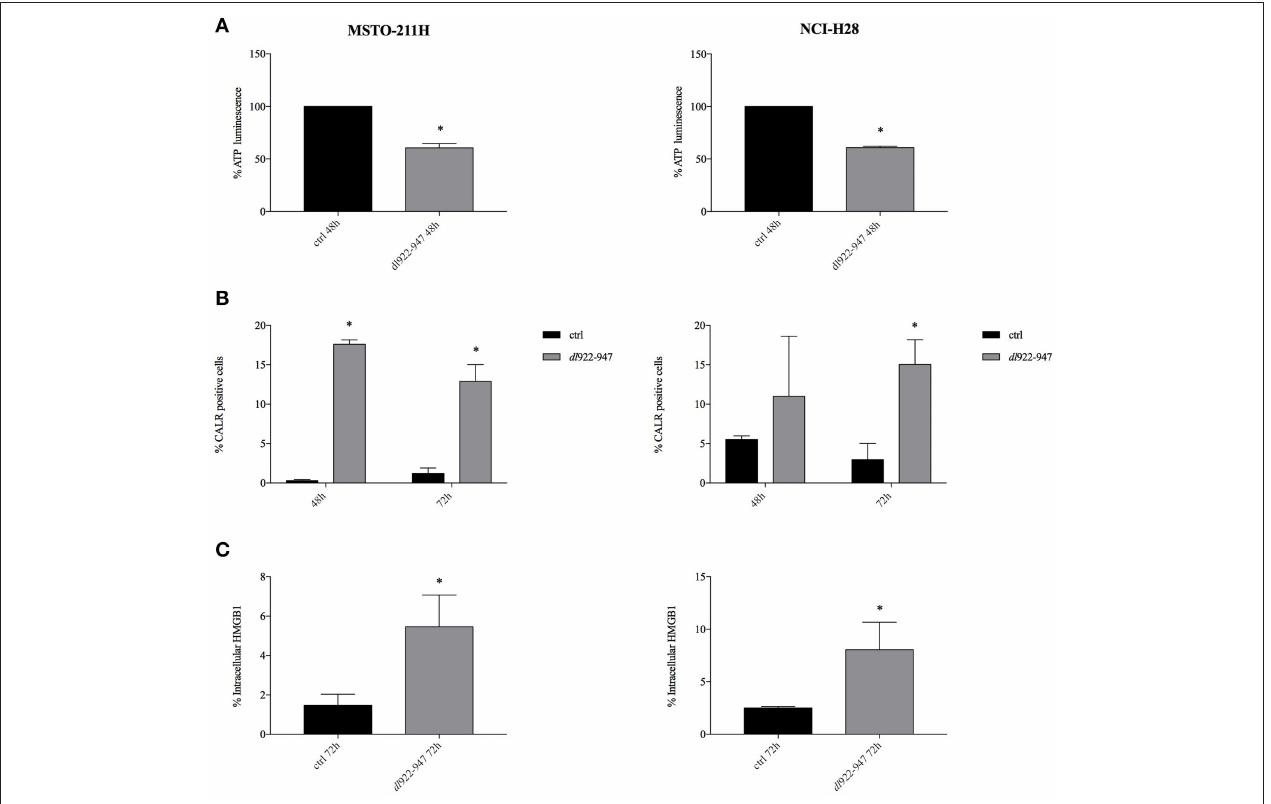
FIGURE 4 | dl 922-947 infection induces ICD in MPM cell lines. Intracellular ATP content (A) , calreticulin cell surface exposure (B) , and HMGB1 secretion (C) evaluated in MSTO-211H and NCI-H28 cells infected with dl 922-947 at its IC50 values with respect to the control cells (black bar). In (A) the histograms report the luminescence percentage indicative of ATP content at 48 hpi. In (B) the histograms report the percentage of calreticulin positive MPM cells at 48 and 72hpi (the mean fluorescence intensity, MFI is reported in Supplemental Table 1 ). In (C) the histograms report the percentage of HMGB1 positive cells at 72hpi (MFI is reported in Supplemental Table 2 ). The histograms show the mean ± s.d. of three independent experiments. The statistical analysis was performed by t -test (* p <